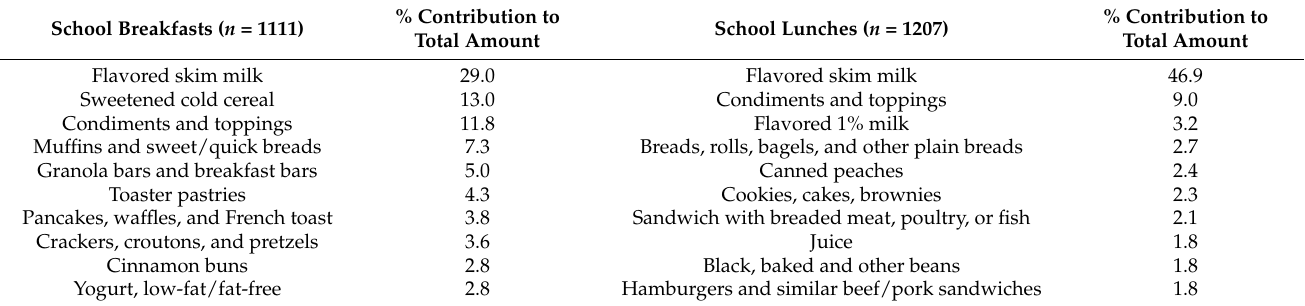
Table 2. Top ten sources of added sugars in school breakfasts and